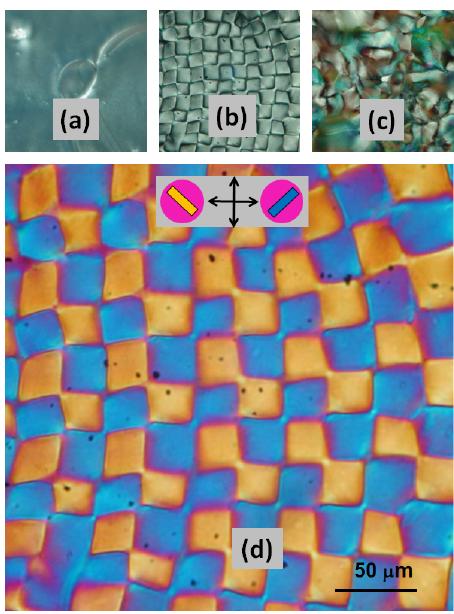
Figure 2. Polarized light images of CNC films (area 300 µm × 300 µm). ( a ) 12 µm; ( b ) 24 µm; ( c ) 36 µm thick films between crossed polars; ( d ) shows the parabolic focal conic image ( b ) magnified between crossed polars with 530 nm red wave plate. Direction of crossed polars shown by arrows; orientation of CNC shown by insert on ( d ). Figure 2b,d adapted from [28].